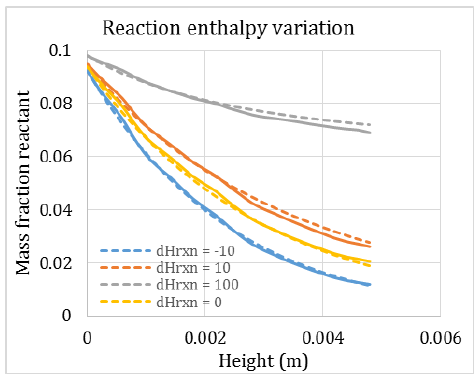
Figure 10. Comparison of axial specie profiles between PR-DNS (solid lines) and 1D simulations (dashed lines) for a packed bed of spherical particles at ( ε = 0.355, Pr = 1, and 𝜙 = 10) for different heat of reactions (dH rxn in kJ/mol).